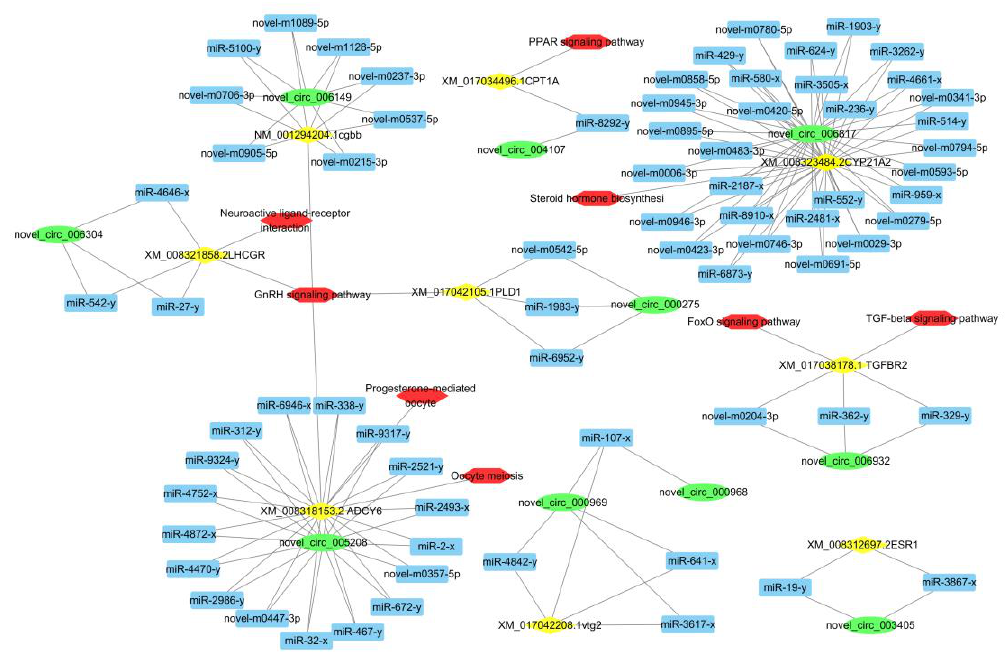
Figure 5. Construction of the circRNA-miRNA-mRNA network using online bioinformatics programmes (circBase, miRTarBase). The green circle indicates circRNA, the blue rectangle indicates miRNA, the yellow diamond indicates the targeted gene and the red hexagon indicates the gene pathway.